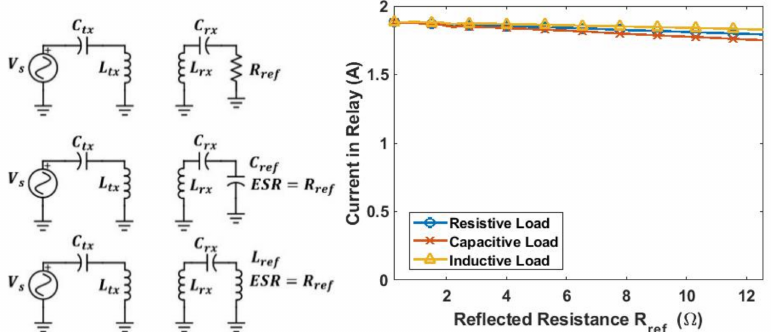
Figure 20. Simulated relay coil current under different loading conditions.